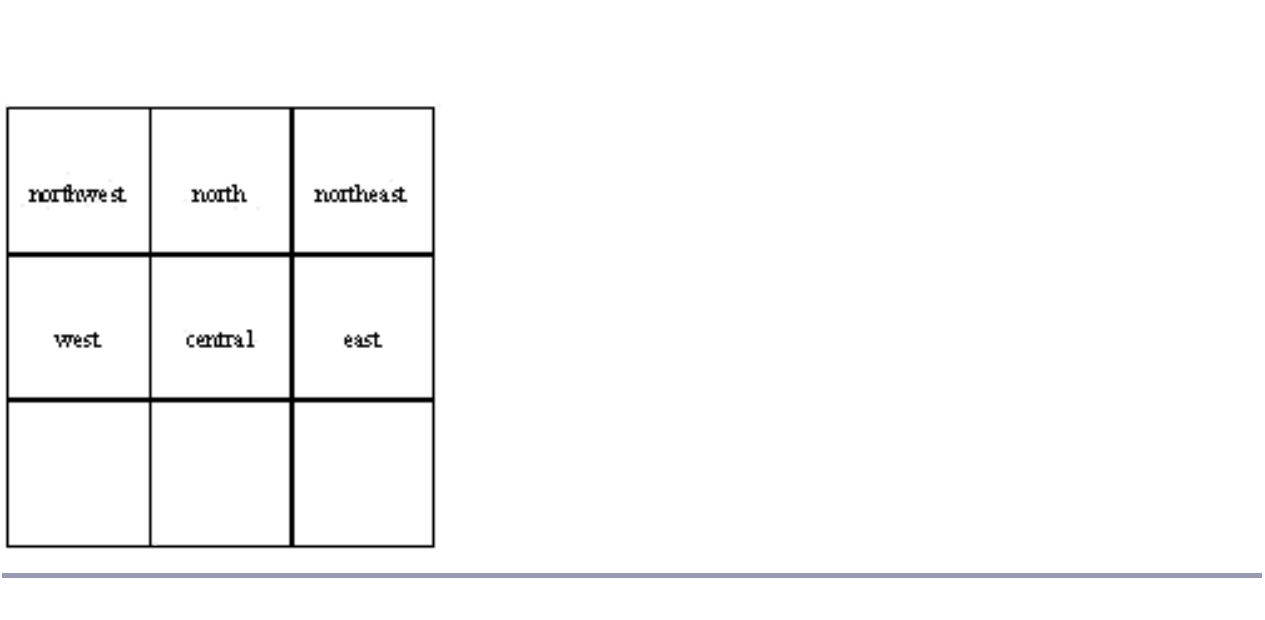
Fig. 3 . Cell reference names for the crack identification and crack removal algorithms.